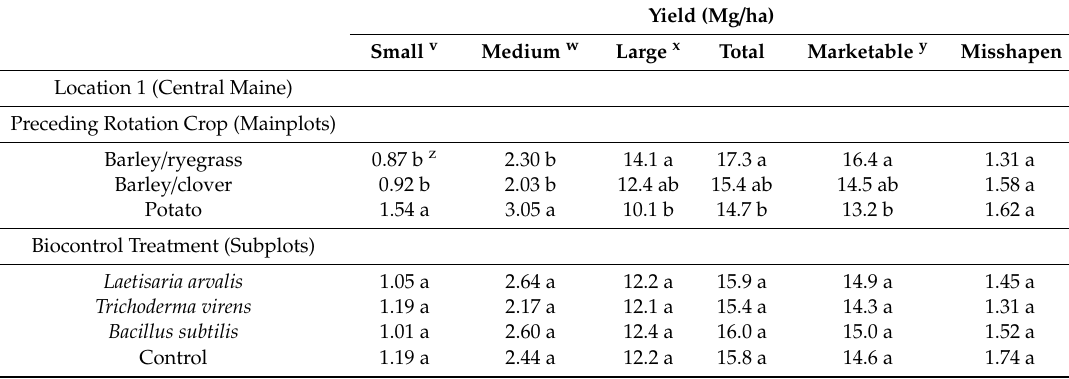
Table 4. Tuber yield by size class for preceding rotation crop or biocontrol